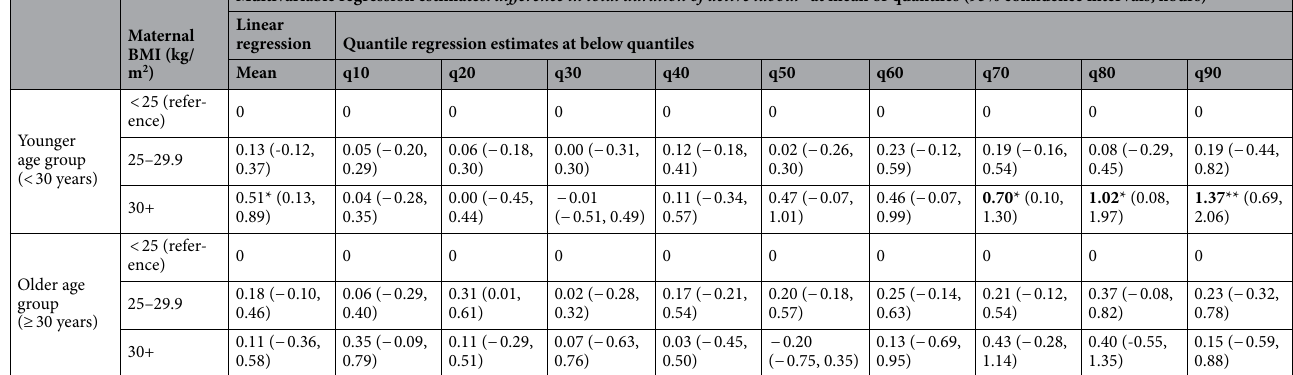
Table 5. Multivariable regression analysis for association of total duration of active labour with maternal early-pregnancy BMI, using the Stockholm-Gotland obstetric database, 2008–2014. Multivariable regression analysis on two age sub-groups separately: maternal early pregnancy BMI categorized into three sub-groups, with adjustment for maternal height (in restricted cubic splines with 3 degrees of freedom), smoking status (dummy variable), co-habitation status (categorical variable), year of birth (categorical variable); stratified on two separate age groups. a Total duration of active labour: the length from the time point of the cervix fully dilated until birth. *p-value < 0.05; **p-value <